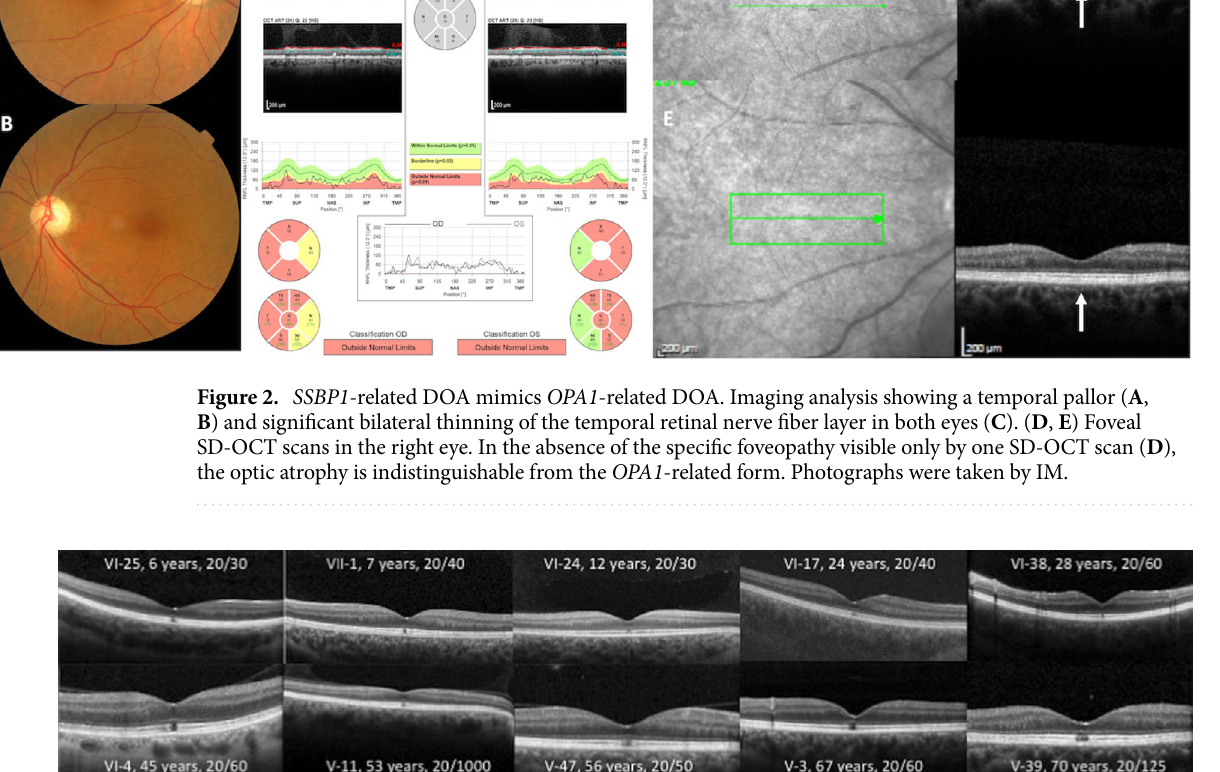
( p < 0.01) for foveal measurements and 210.61 ± 25.69 versus 230.59 ± 17.54, ( p = 0.01) for central macular thickness.